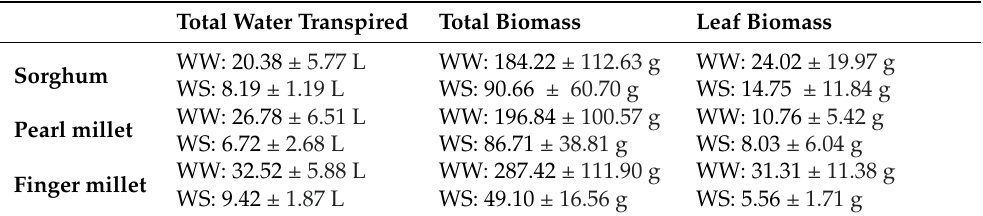
Table 1. Mean and standard deviation values for well-watered (WW) and water-stressed (WS) replications of the three crops.